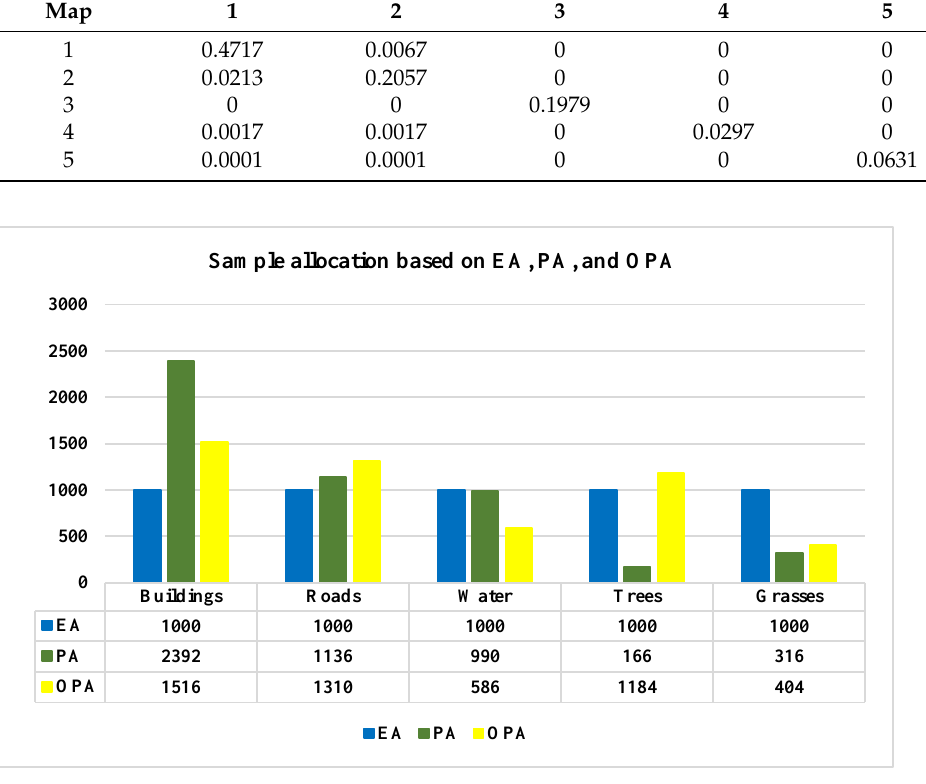
Figure 6. Comparison of the accuracy absolute bias between the three distribution methods and ground truth (the blue bars show the bias between the EA accuracy and ground truth. The green bars show the bias between the PA accuracy and ground truth. The yellow bars show the bias be- tween the OPA accuracy and ground truth).